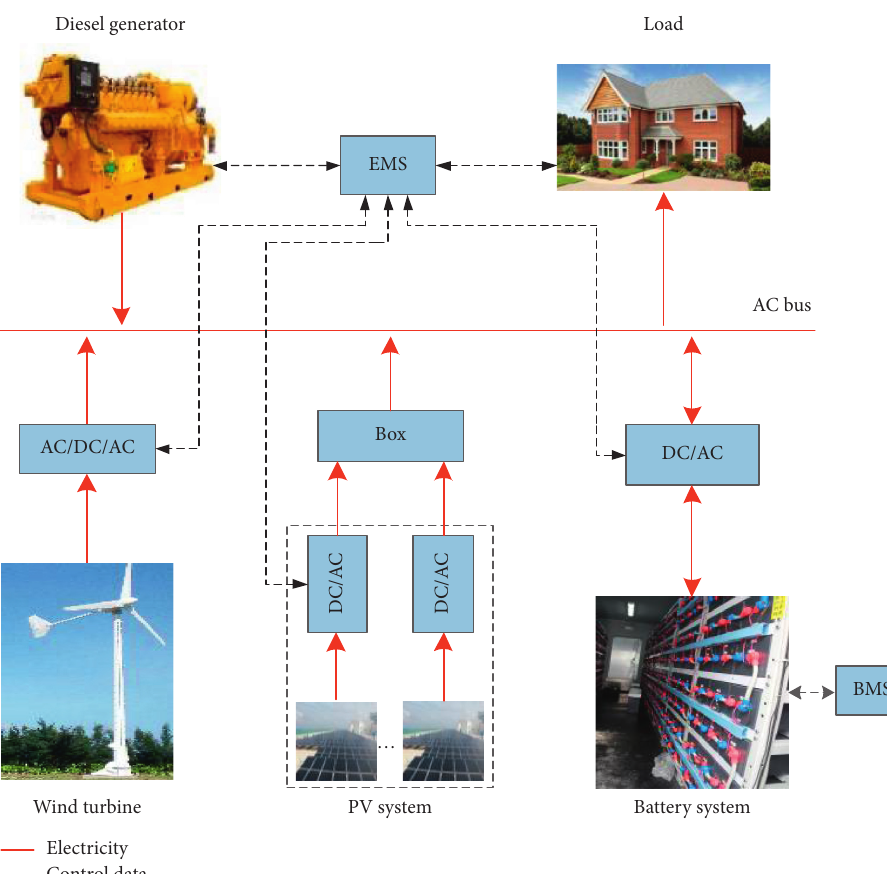
Figure 1: The schematic configuration of a PV-wind-battery-diesel stand-alone microgrid